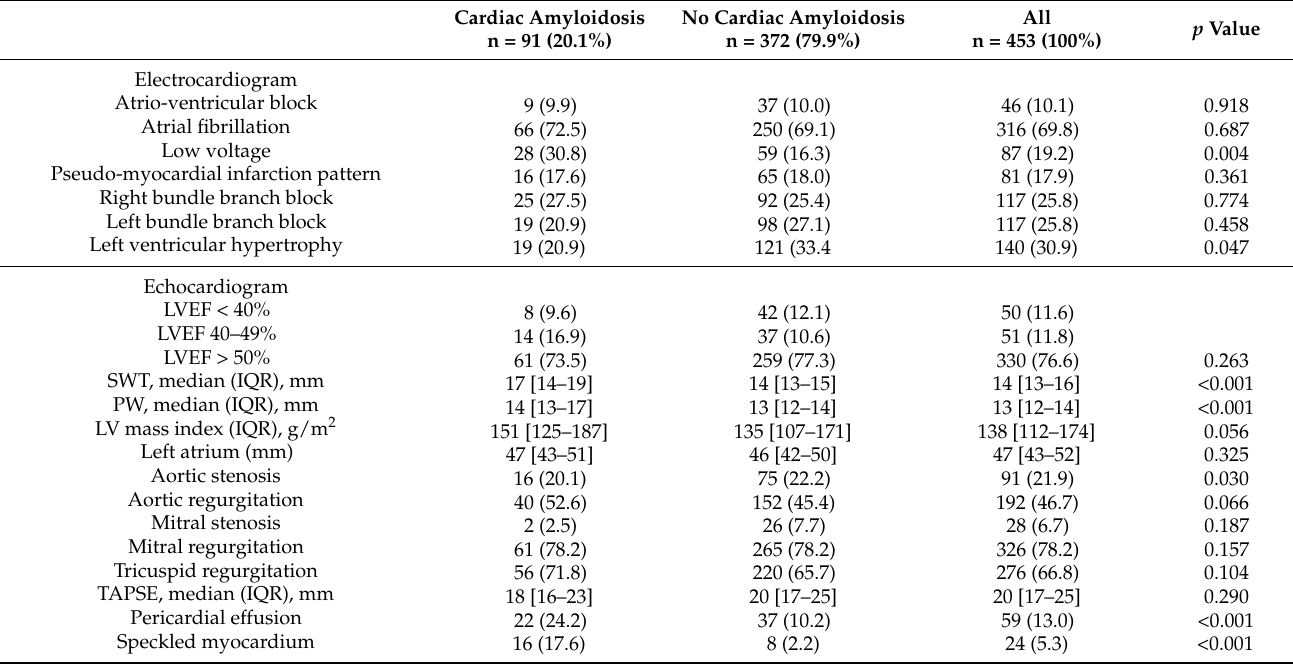
Table 2. Electrocardiogram and echocardiogram parameters. Table 1. Baseline characteristics of the population.